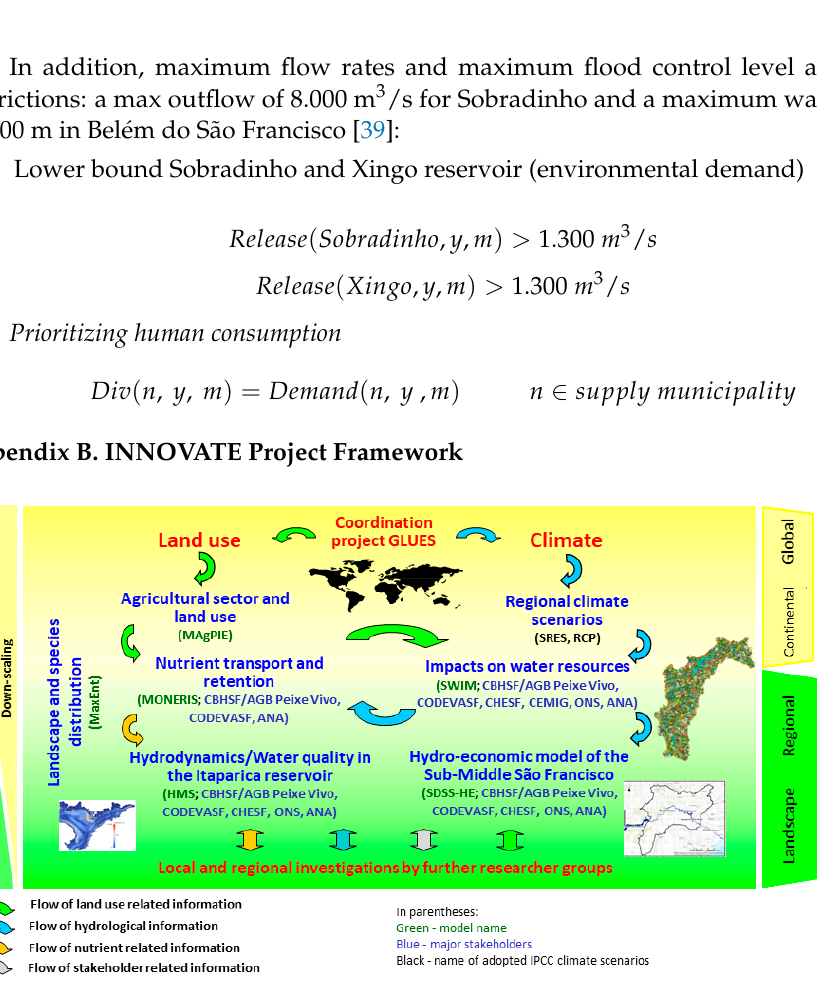
Figure A1. Overview: model chain and flow of information.